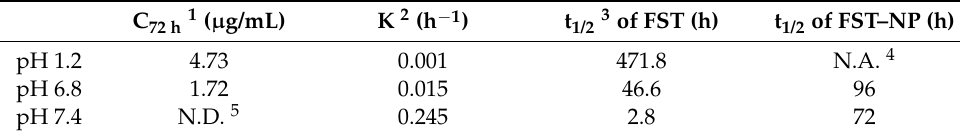
Table 5. Degradation assessment of FST in different